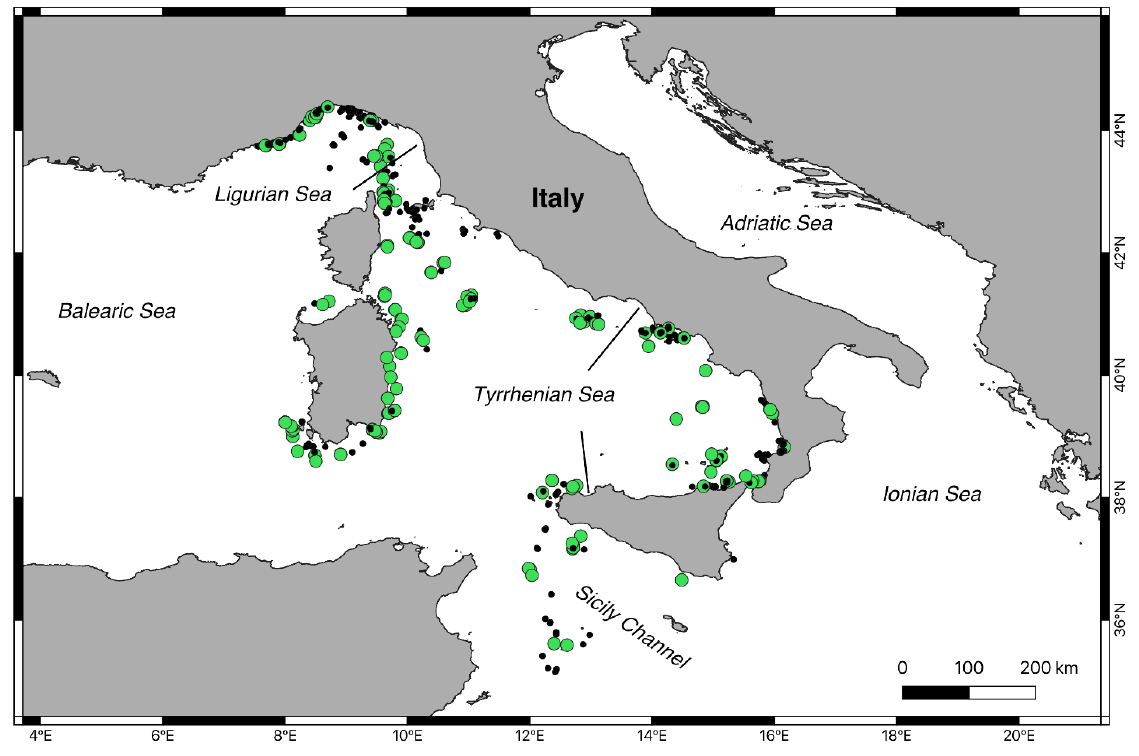
Figure 1. Distribution map of the investigated sites. Sites including at least one record of brachiopods are indicated with green dots, otherwise with black dots.